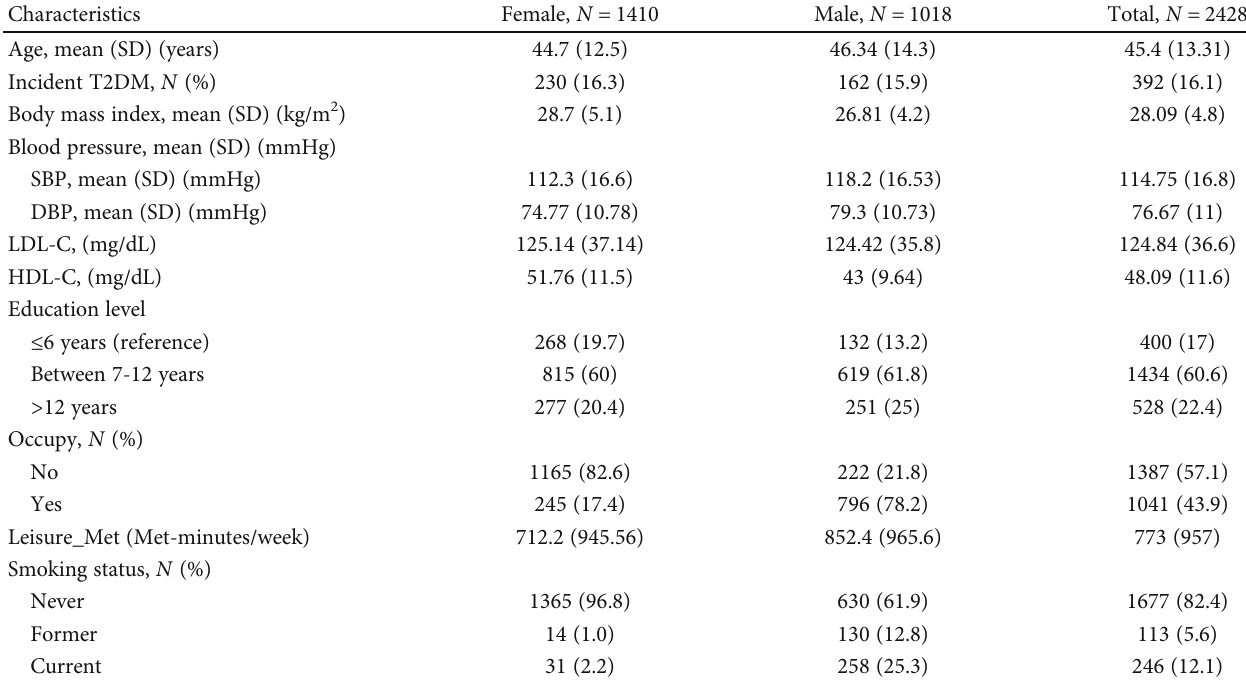
Table 1: Distribution of demographic variables of the study